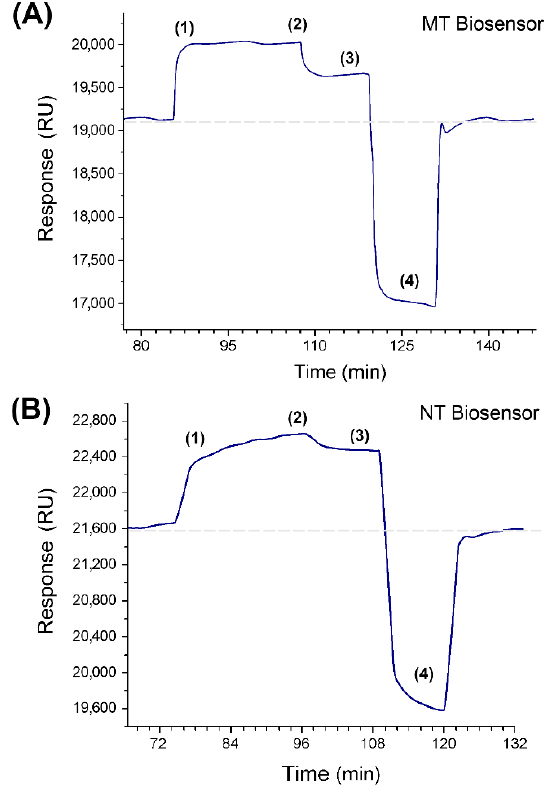
Figure 3. Response sensorgrams for a 40 nM solution of MT-C ( A ) and NT-C ( B ) injected into the respective biosensors, highlighting the different stages during the hybridization process of complementary strands. (1) Association, (2) equilibrium, (3) dissociation, and (4) regeneration.